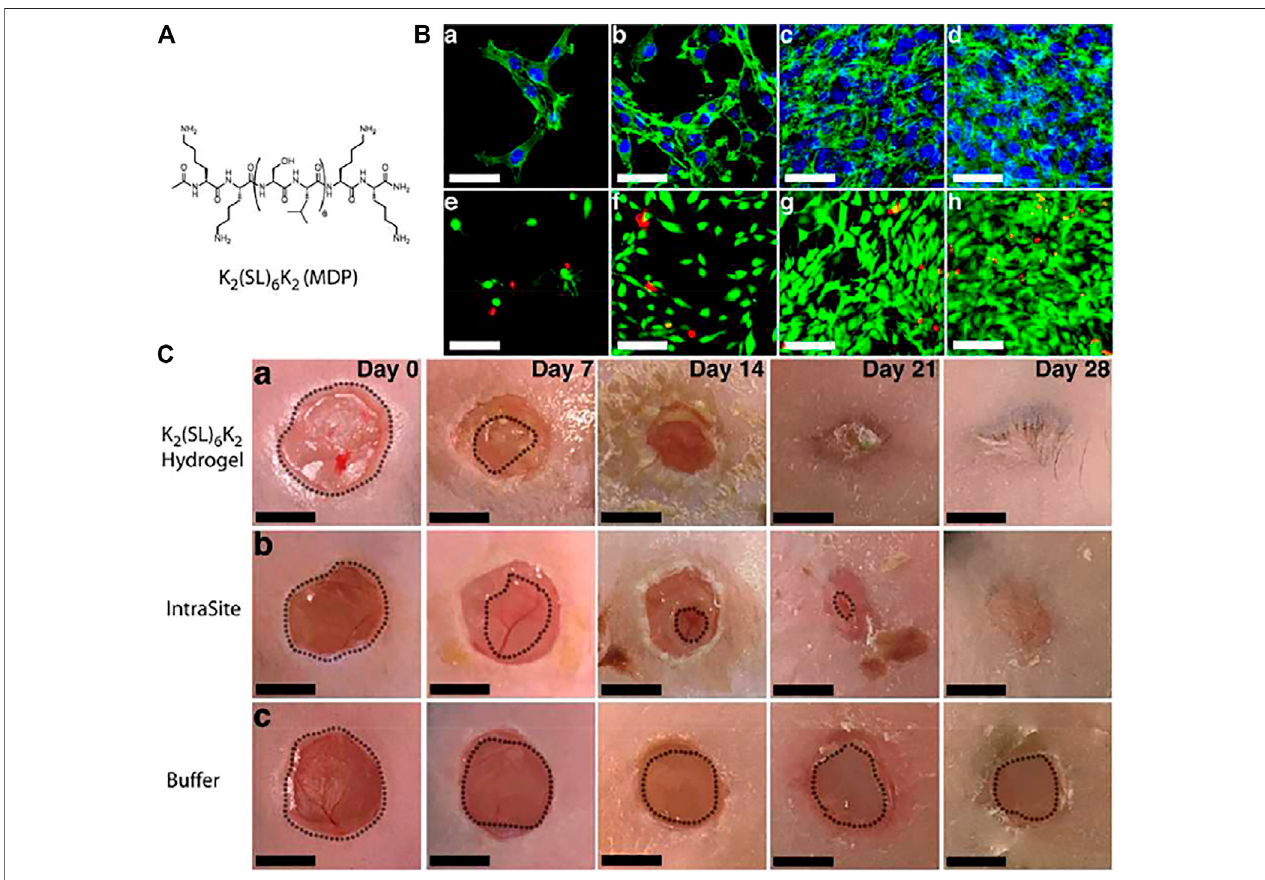
FIGURE 6 | Application of peptide hydrogel for wound healing. (A) Chemical structure of the peptide hydrogelator (MDP) used for the study. (B) 3D cell culture of NIH-3T3 fi broblasts in MDP hydrogel. Images of encapsulated NIH-3T3 fi broblasts within the MDP hydrogel after (a) 3, (b) 7, (c) 10, and (d) 14 days and stained with Alexa488-phalloidin(green)andDAPI(blue)tovisualizetheactincytoskeletonandnuclei,respectively.Scalebars (cid:1) 50 μ m.CalceinAm(green)andethidiumhomodimer- 1(red)wereusedforlive − deadstainingof fi broblastsat(e)day3,(f)day7,(g)day10,and(h)day 14.Scalebars (cid:1) 100 μ m. (C) Expeditedwoundclosureindiabetic mice by MDP hydrogel. Images of wounds taken for (a) MDP hydrogel, (b) IntraSite, and (c) buffer to measure wound contraction and wound closure (outline) in ImageJ showing faster healing with MDP hydrogel. Scale bars (cid:1) 5 mm. Reproduced with permission (Carrejo et al., 2018). Copywrite 2018 American Chemical Society.